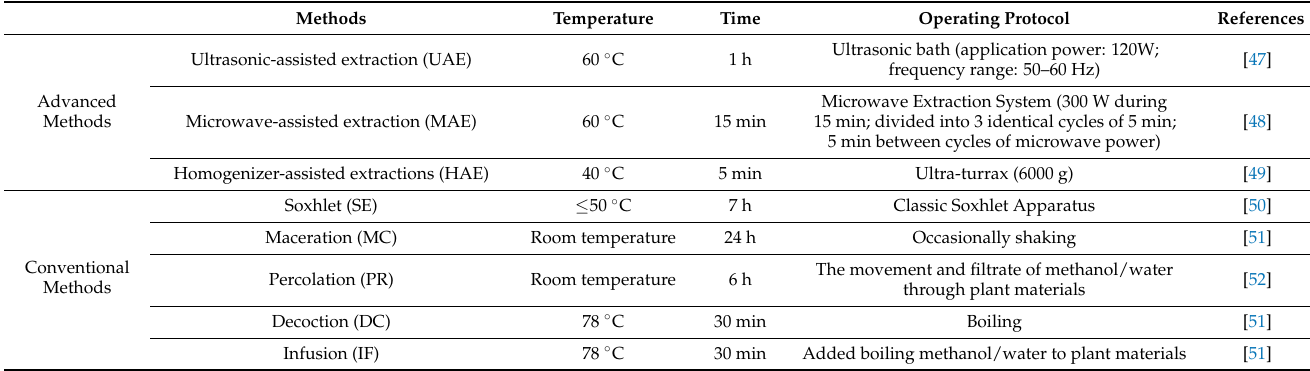
Table 4. Detailed explanation of the extraction procedures used in this